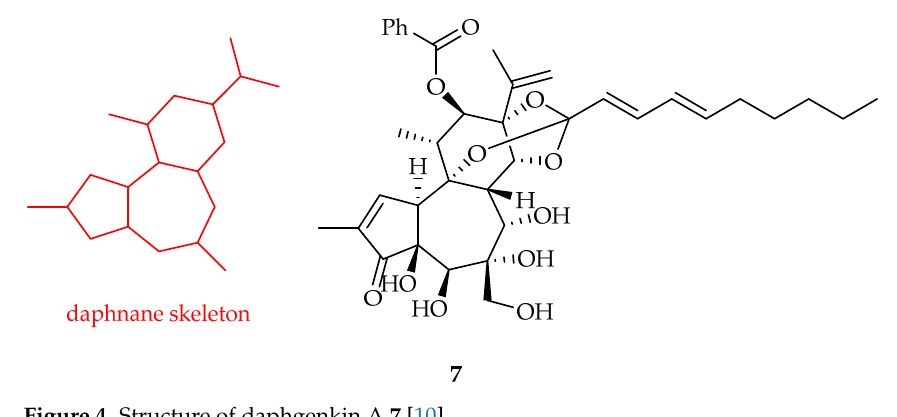
Figure 4. Structure of daphgenkin A 7 [10]. Four undescribed compounds, yuanhuakines A–D 8 – 11 , were also isolated from the flower buds of Daphne genkwa Sieb. et Zucc. by ethanolic extraction and subsequent parti- tioning with EtOAc and CH 2 Cl 2 [11]. Their structures were elucidated by spectroscopic analyses, ECD calculations, and single-crystal X-ray diffraction analysis. The new com- pounds showed inhibitory activity against the A549, Hep3B (human liver cancer), and MCF-7 cell lines, with IC 50 values ranging from 7.83 to 23.87 µ M. The MMT assay was used, and cisplatin, sorafenib, and doxorubicin were used as positive controls (Figure 5).